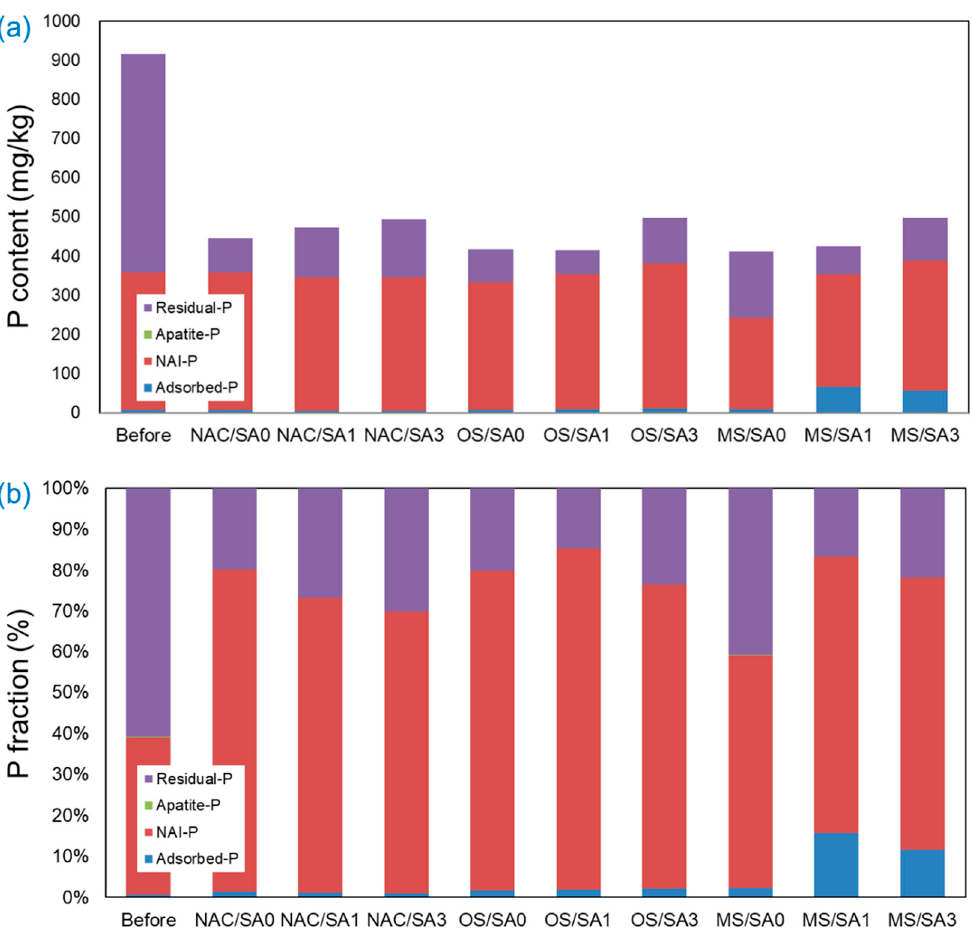
Figure 6. Adsorbed-P, NAI-P, Apatite-P, and Residual-P fraction of P present in the sediments beneath the overlying water and capping layer. (a) P content (mg/kg) and (b) P fraction (%)